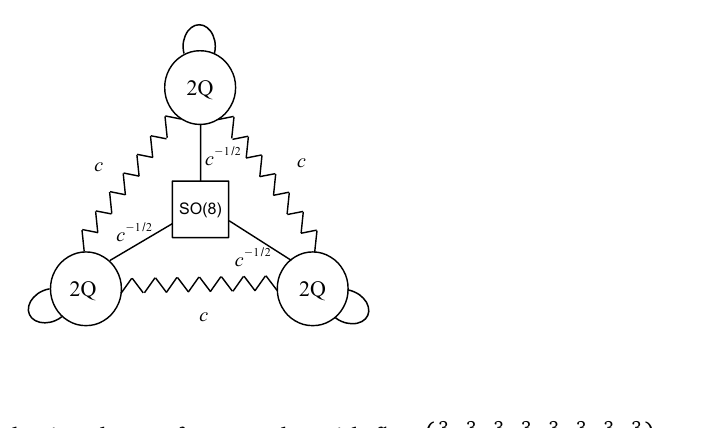
Figure 15: Gluing three basic tubes to form a tube with flux